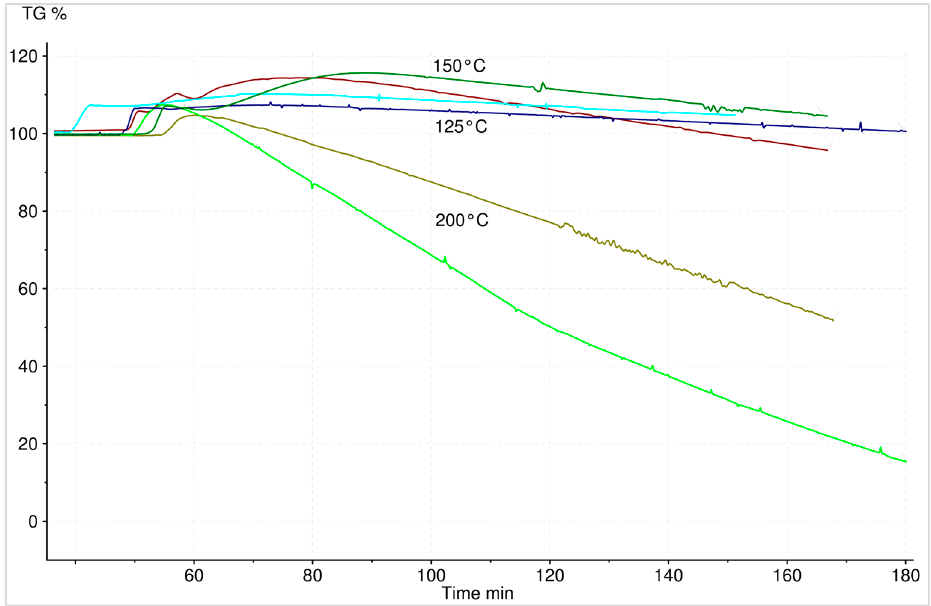
Figure 8. Hydration of 9.8 and 1.3 mg B 2 O 3 at constant water vapour mass flow (5 g/h H 2 O within 100 mL/min N 2 )—temperature influence on the volatility of the resulting H 3 BO 3.